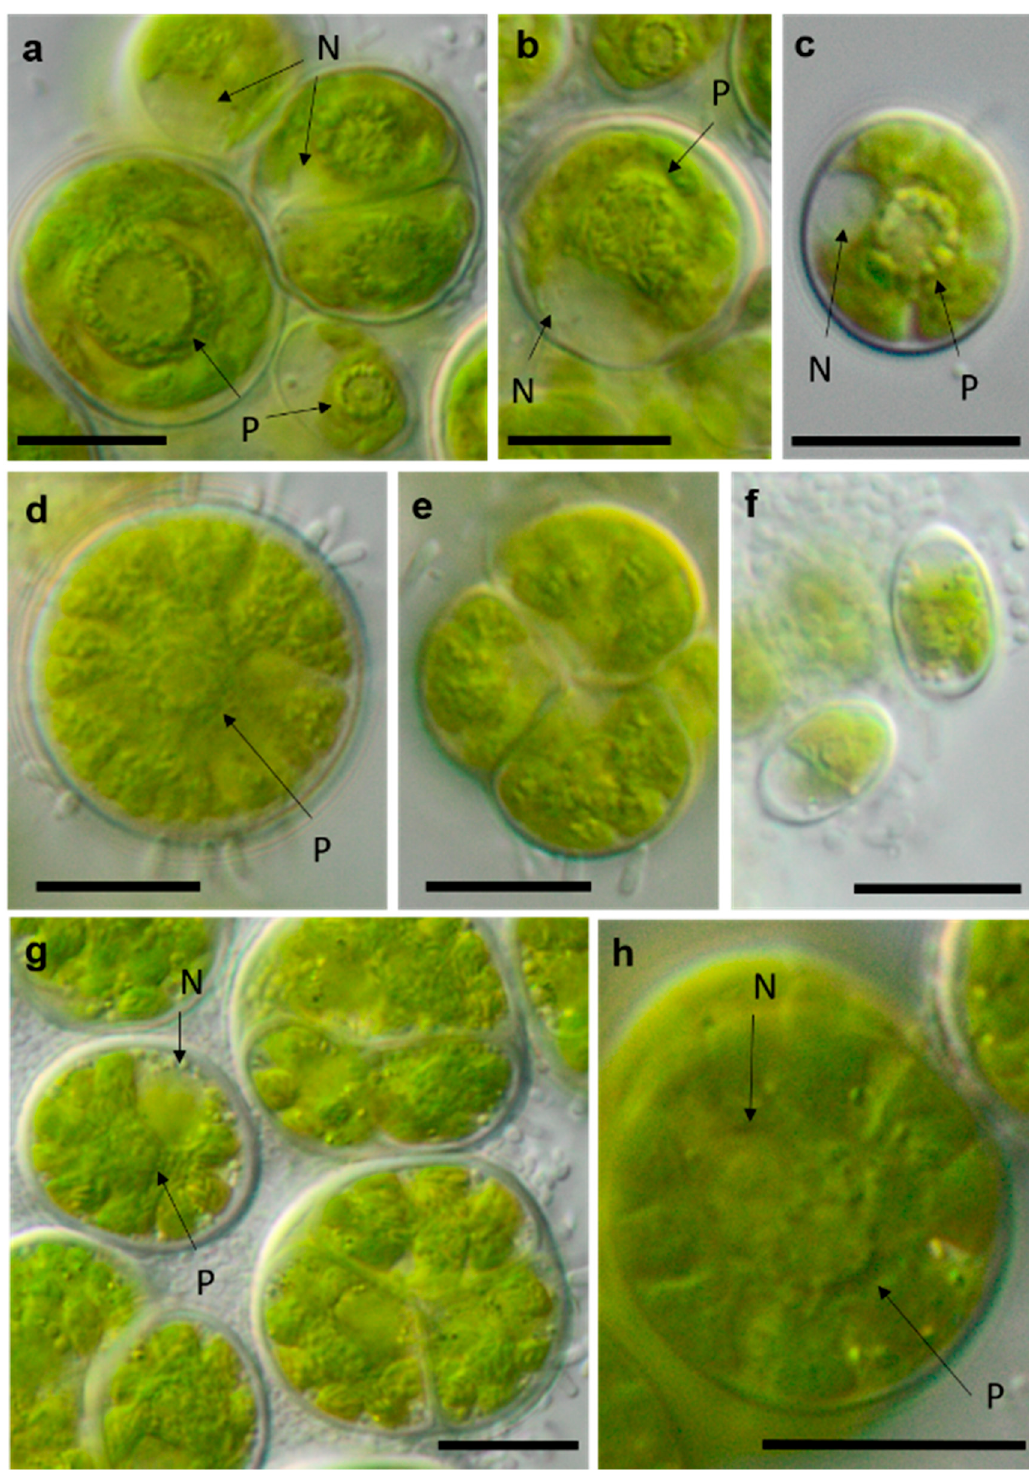
Figure 15. Photomicrographs of Chlamydomonadales isolates. ( a , b ) cf. Spongiococcum TT-3-1-M; ( c – e ) Borodinellopsis sp. NN-2-D ( c ) juvenile cell and ( d ) mature cell with lobed chloroplast; and ( f – h ) Borodinellopsis texensis NN-4-1-E ( f ) zoospores, ( h ) single cell with prominent nucleus, and one pyrenoid surrounded by several fine starch grains. Arrow labels: N = nucleus and P = pyrenoid. Scale bars: 10 µm.